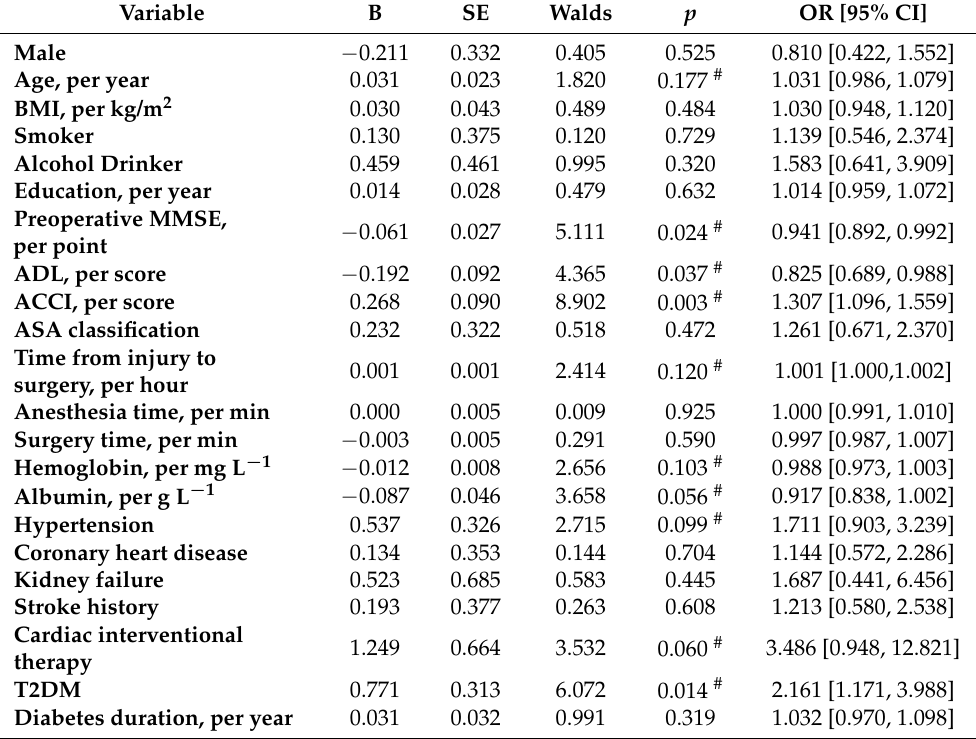
Table 6. Univariate logistic